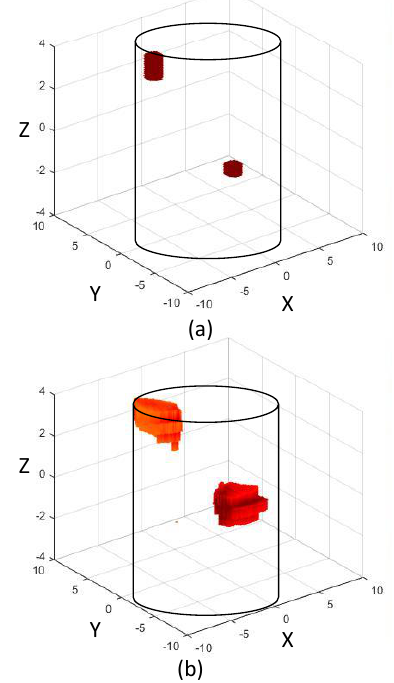
Figure 5. Two sets of measurements, S 1 and S 2, are being taken at times, t = t 1 and t = t 2 , respec- tively.